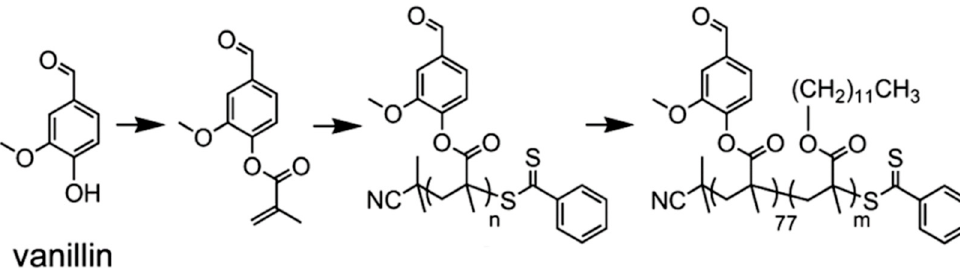
Figure 10. Renewable homopolymers and block copolymers synthesis via RAFT polymerization using vanillin-based methacrylate monomers. Reproduced with permission [44].